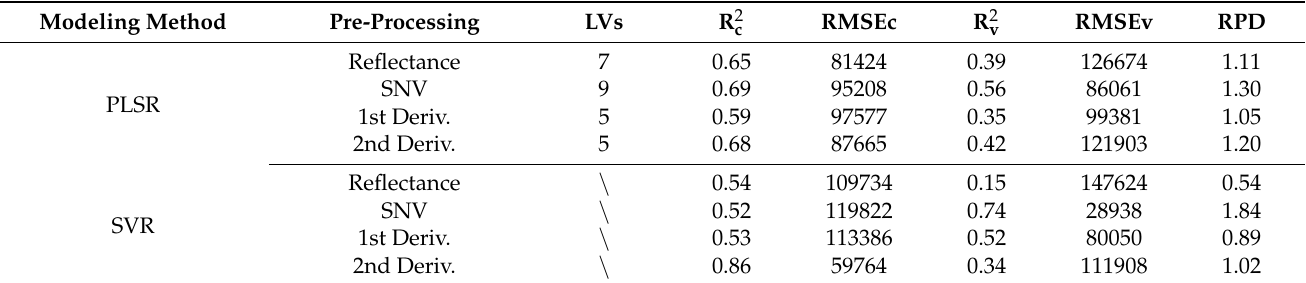
Table 1. AFB 1 prediction results of models developed by original AFB 1 values. Modeling